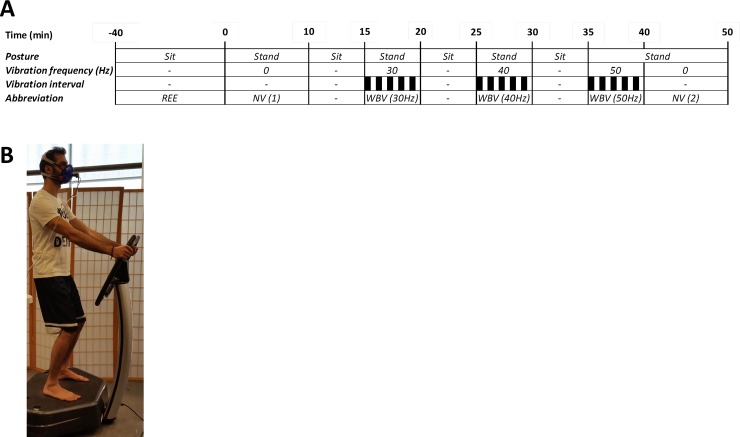
Panel A: Schema showing experimental protocol for intermittent side-alternating whole body vibration (WBV) across varying frequencies. Black bars represent periods of WBV, with each frequency (30, 40 or 50 Hz) assessed over 5 cycles of 30 s vibration and 30 s rest (on the platform), and separated by 5 min rest on a comfortable chair. EE at each vibration frequency was calculated as the integrated mean across the entire 5 min intermittent WBV period (i.e., including measurements obtained during both the 30 s vibration and 30 s rest intervals). Black bars indicate vibration periods. REE: resting energy expenditure while sitting in a comfortable seat (sit); NV: participant standing on platform with no vibration. Panel B: Photo of the position adopted by subjects on the vibrating platform.